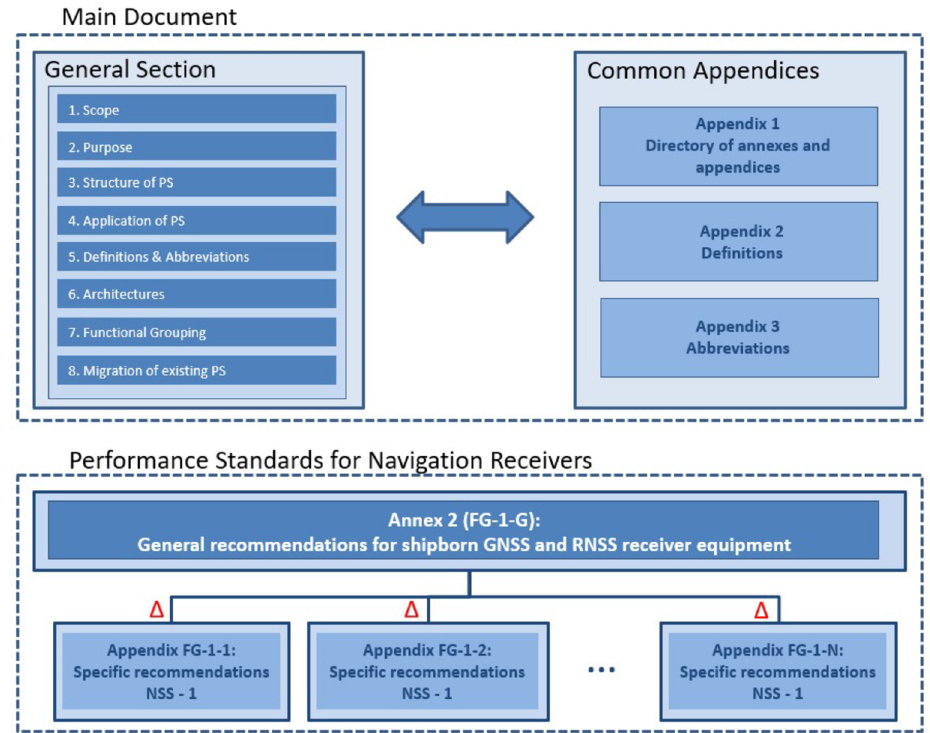
Figure 13. Structure of the IMO generic GNSS performance standards (based on [45]).